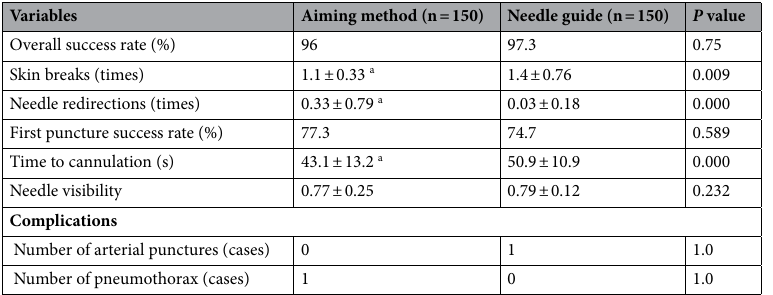
Table 1. Performance of resident with aiming methods in human study. Data were described as mean ± standard variation or proportion. a P < 0.05 compared with the needle guide group (group NG). Needle visibility: the fraction of time the needle tip was visualized during the insertion. Time to cannulation: The time from the skin was punctured to guide-wire insertion. First puncture success rate: The percentages of cases who were catheterized in first puncture try without needle redirections.